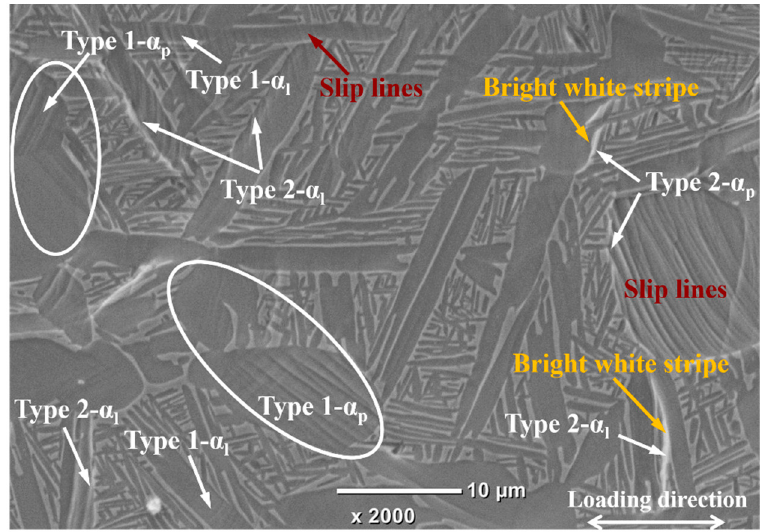
Figure 7. The typical strain localization regions and corresponding grid change within equiaxed α ( a ) and within lamellar α ( b ) at macro-strain of 4.7%.